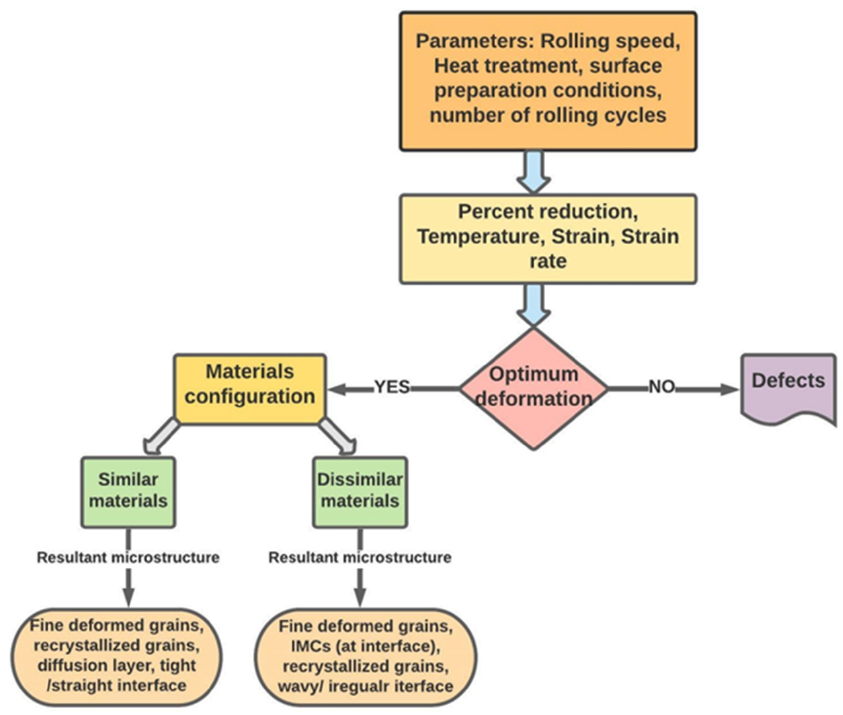
Figure 7. Overall microstructural evolution in RB processes. Chekhonin et al. [65] found that for ARB processed aluminum laminates, yield strength, and ultimate tensile strength increases with increasing number of processing cycles. The authors reasoned that this rise in strength was related to grain refinement and intensification in the dislocation density. Researchers [56] investigated the tensile strength of Mg-Al ARB laminated composites which were preheated in both rolling and transverse directions before the process. During the ARB processing of pre-heated samples, tensile strength and elongation decreased significantly in the rolling direction despite initial increase along with strong anisotropy in yield strength. The authors reasoned that neck- ing and rupture happened in the hard layer with subsequent ARB cycles, as instabilities originating from the variances in the parent metals caused fracture of the Al layer, and the remaining strength provided by Mg layers was insufficient to prevent deformation around the Al layer, resulting in degradation in strength. Researchers [66] investigated the joint efficiency of hot vacuum roll bonded Zr–AISI 321 and Zr–C22E steel joint and found greater joint strength than in the less durable material in both configurations. Luo et al. [67] joined Ti to stainless steel with Nb as an interlayer using HRB. The authors observed degradation in tensile strength with increasing temperature because of enhancement in the volume frac- tion of the IMCs. A similar trend was noticed by Saboktakin et al. [68] when investigating the mechanical properties of HRB Fe-Ti joints with copper foil as the interlayer.